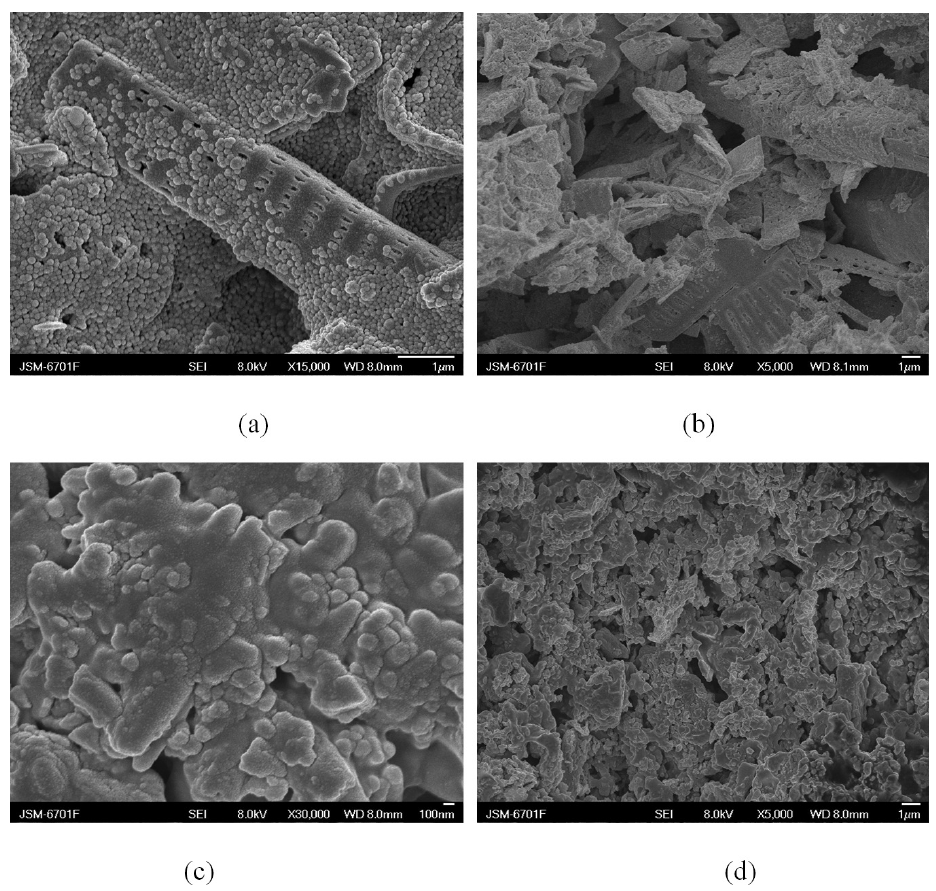
Figure 10. SEM images of PoSt-g-BMD-C and traditional interior wall coatings ((a) Surface of PoSt-g-BMD-C; (b) Cross Profile of PoSt-g-BMD-C; (c) Surface of traditional interior wall coatings; (d) Cross Profile of Traditional interior wall